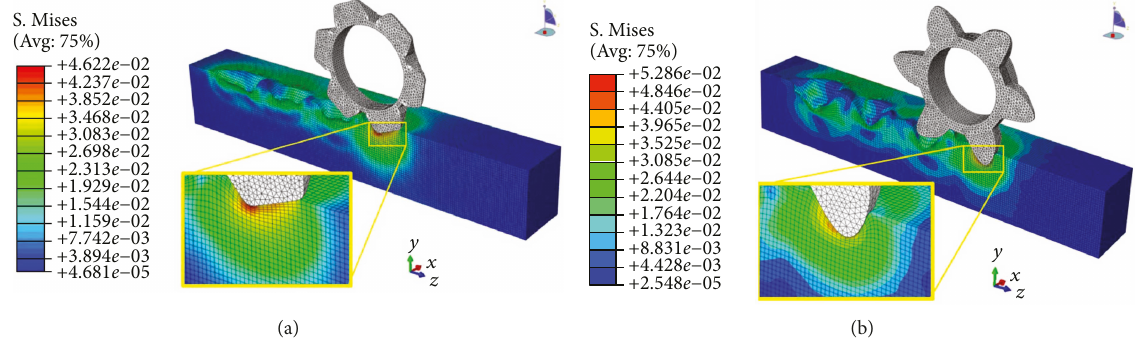
Figure 15: Penetrating stage. (a) Conventional toothed wheel. (b) Bionic toothed wheel.